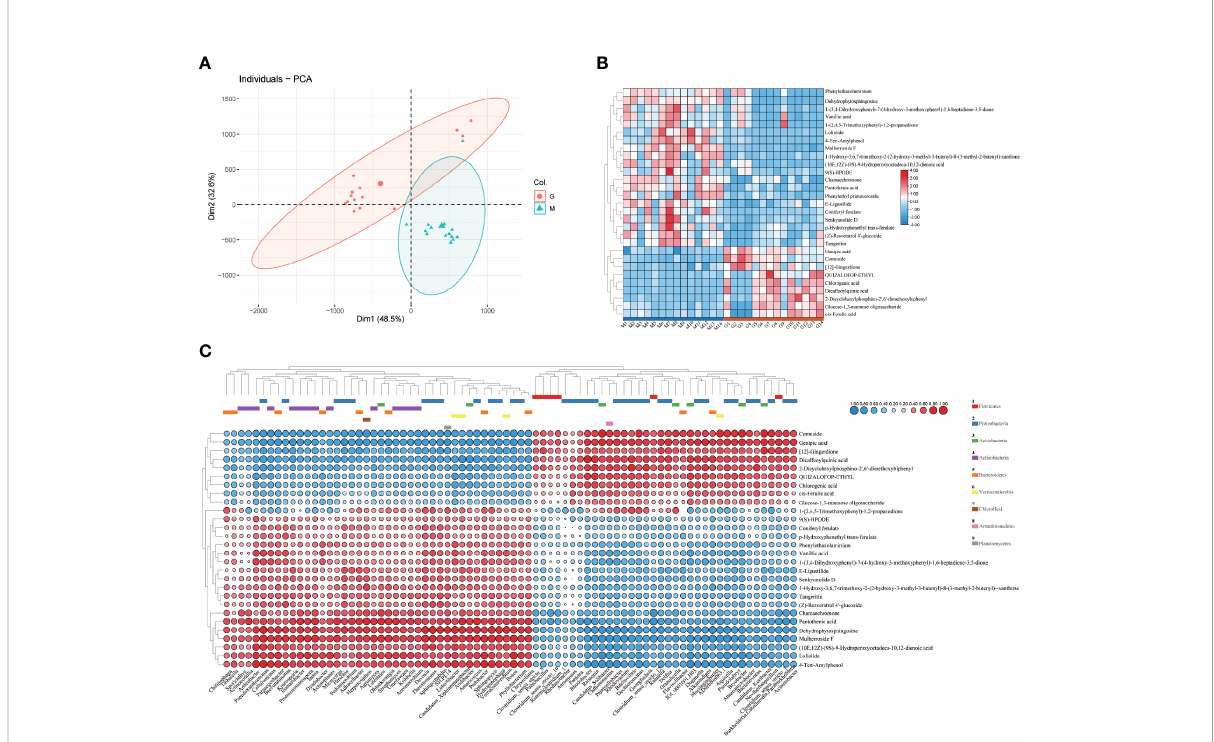
FIGURE 4 PCA scores for the comparison of metabolomic pro fi les between M and G (A) . Hierarchical clustering heatmap of the differential metabolites of A. sinensis between group M and G (B) . Covariation between differential abundant microbes and metabolites match against standards between group M and G (Spearman ’ s rank correlation) (n=3) (C)